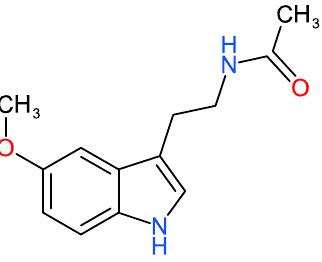
Figure 1. Chemical structure of Melatonin.